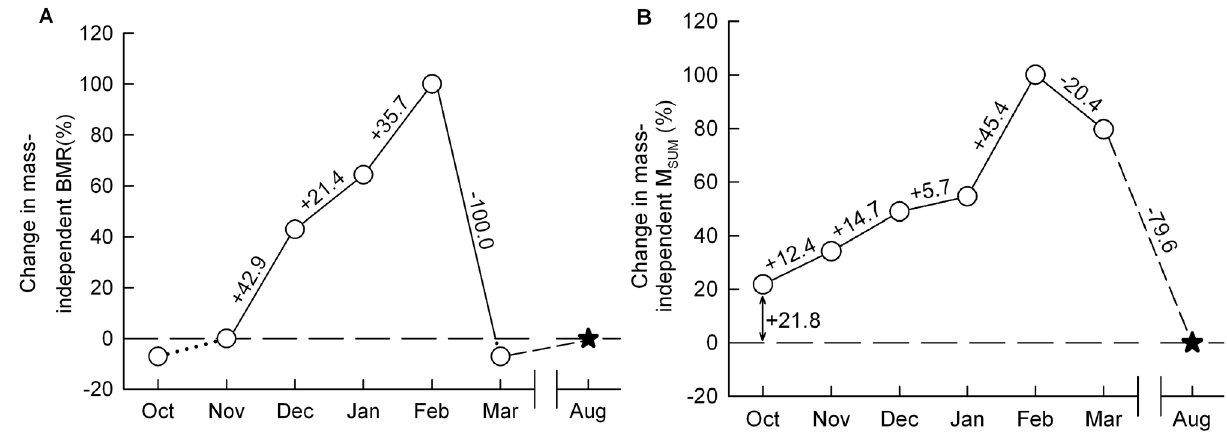
Figure 4. Visual representation of the monthly winter increment in metabolic performance. Increment in mass-independent BMR (A) and M (B) relative to summer values. Data measured in August are used as the summer phenotype reference point SUM (August = 0%, black star, dashed line) while maximal levels of BMR and M recorded in winter are considered representative of SUM the “peak” winter phenotype (February = 100%). Monthly changes in metabolic performance (values above lines) are presented in percent of total inter-seasonal difference. Dotted lines represent BMR variations below the summer reference point. doi: